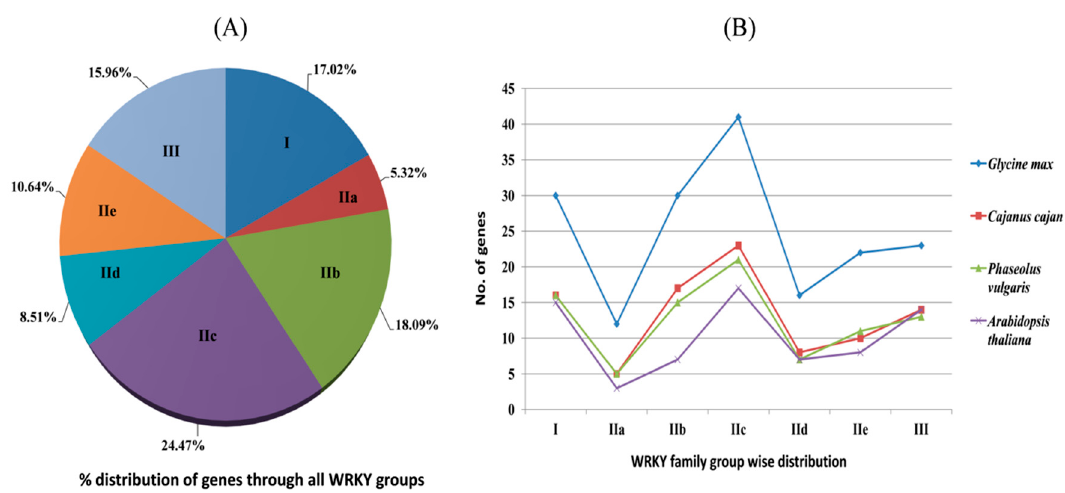
Figure 2. Distribution of WRKY group members. (A) Percentage of genes in different WRKY groups of pigeonpea genome, and (B) Comparison of WRKY genes distributed in different groups identified in pigeonpea and across different crop species including Glycine max, Cajanus cajan, Phaseolus vulgaris , and Arabidopsis thaliana.